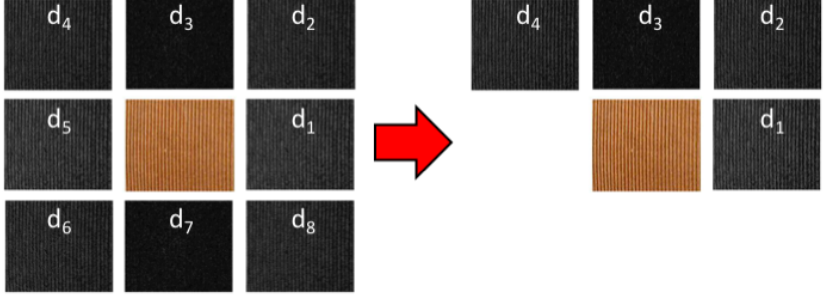
Figure 5. Schemas of the computation of CLOSIB 8,1, θ ( left ) and H-CLOSIB 8,1, θ ( right ) using the example of Figure